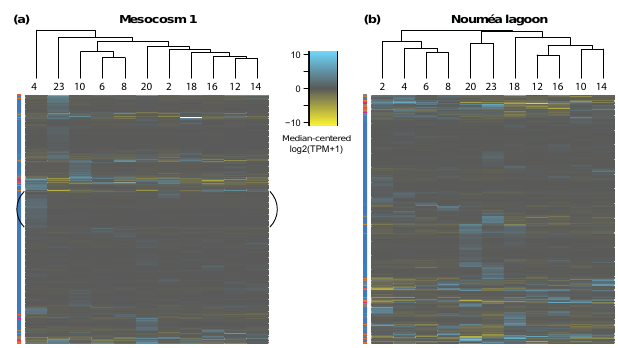
Figure 2. Heat map showing the expression (median-centered log 2 (TPM + 1)) of all significantly differentially expressed tran- scripts in all samples taken from mesocosm M1 (a) and outside (b) . Clustering of samples and transcripts was done using Euclidean distance measures followed by average agglomerative clustering (hclust(method = average)). Note that in (a) samples T2 and T4 cluster far away from the other samples. These were taken before the phosphate spike. In M1, T4 is distinguished by a large cluster of genes upregulated at that time point, most of which belong to the Rhodobacteraceae family. The general clustering along the timeline is evident inside and outside of M1.